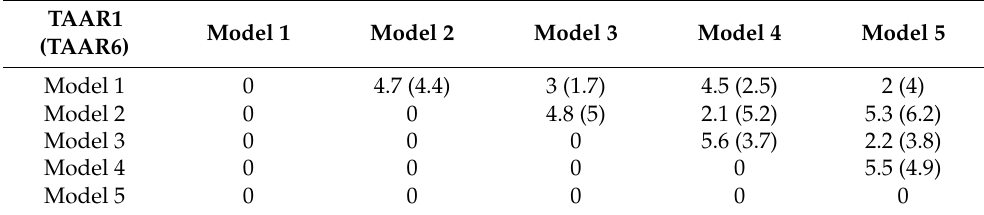
Table 6. C α RMSD between TAAR1 (TAAR6) receptor models.